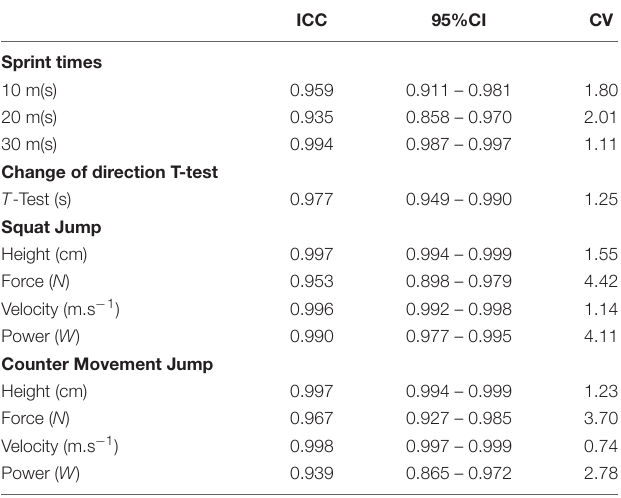
TABLE 4 | Intra-class correlation coefficient showing acceptable reliability for measures of sprint, agility, squat jump, and counter-movement jump